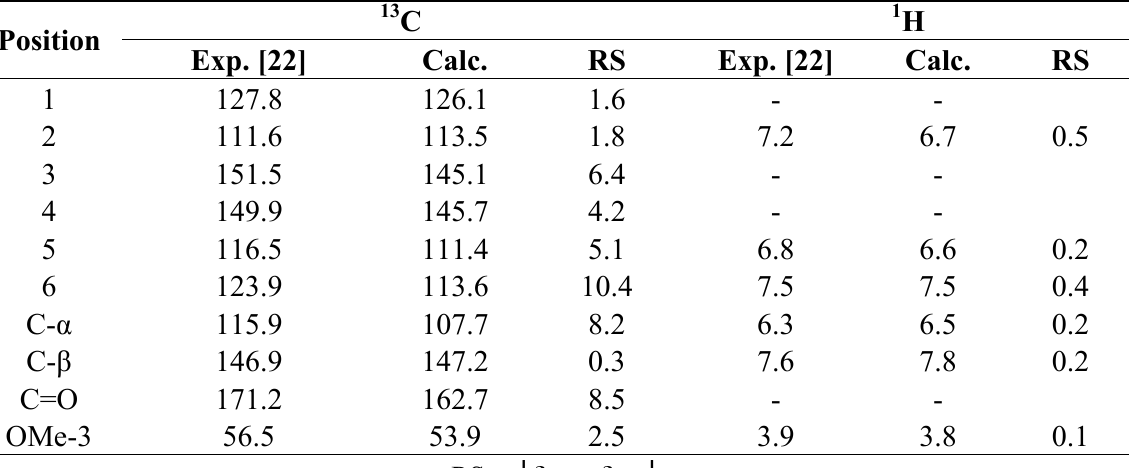
Table 3. Experimental [22] 1 H and 13 C NMR data, calculated 1 H NMR data (Calc.) with B3LYP/6-31+G(d,p) and residues (RS) in ppm for the FA. Position